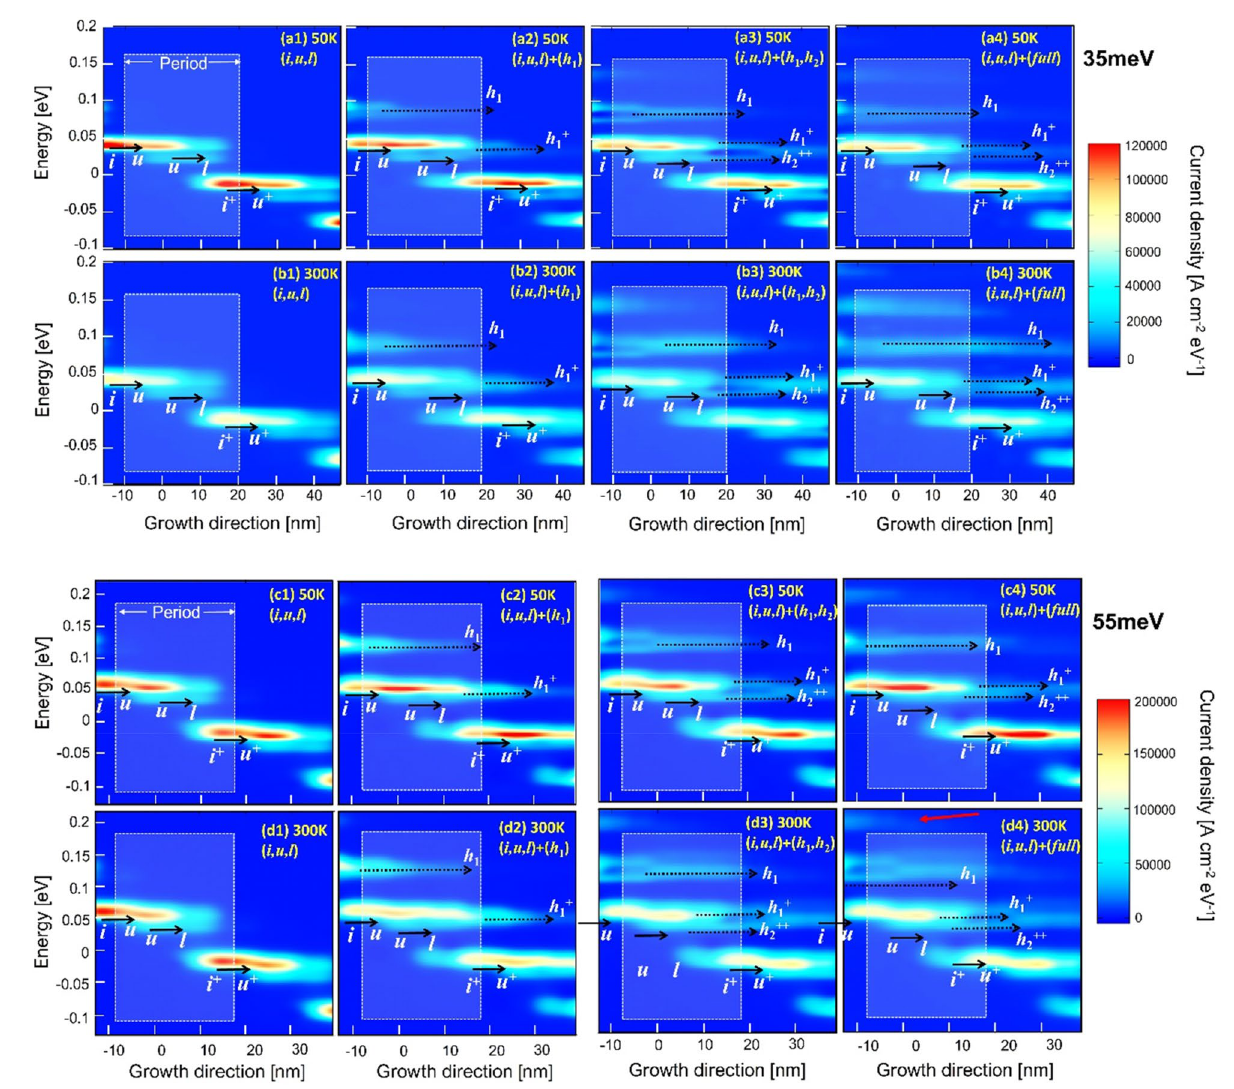
Figure 3. The spatial and energy resolved current mappings under the operating bias condition at low and high temperatures (50 K and 300 K). Figures ( a1 – a4 ) and ( b1 – b4 ) indicate the mappings for the 35 meV design; Figures ( c1 – c4 ) and ( d1 – d4 ) indicate the mappings for the 55 meV